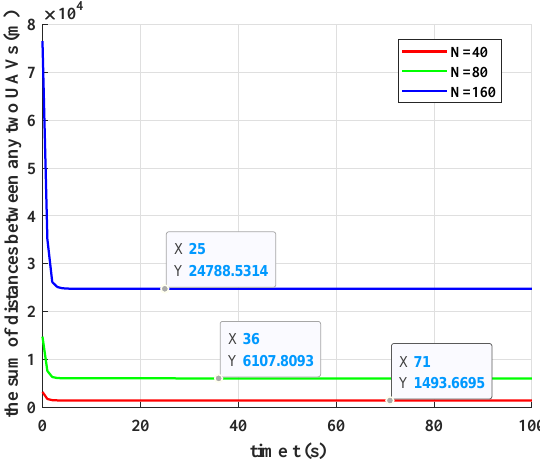
Figure 5. Scalability effect of flocking system (1) under control protocol